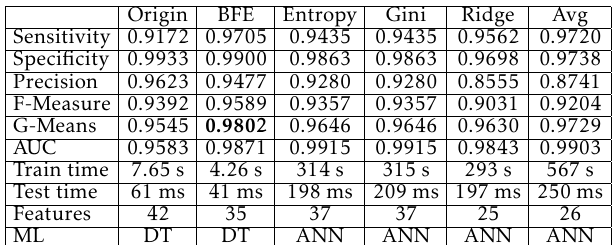
Table 18. Compare IG-BFE with other algorithms on ANALYSIS.